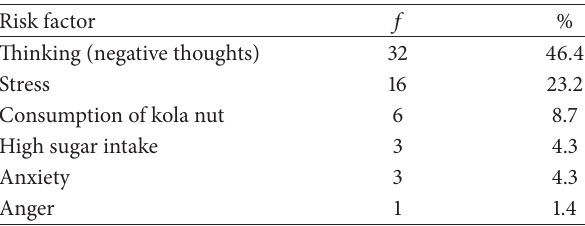
Table 3: Incorrect risk factors mentioned by participants ∗ . Risk factor 𝑓 %